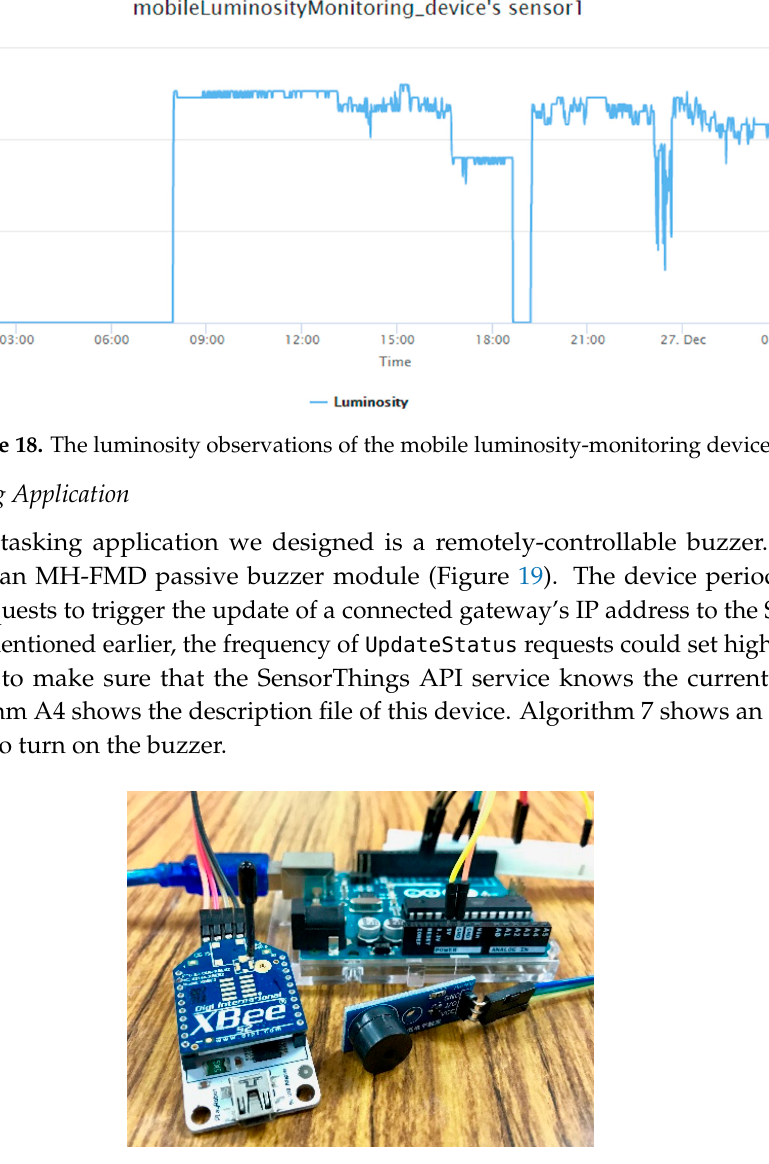
Figure 19. The remotely-controllable buzzer device. Algorithm 7. An example task to ring the buzzer five times.